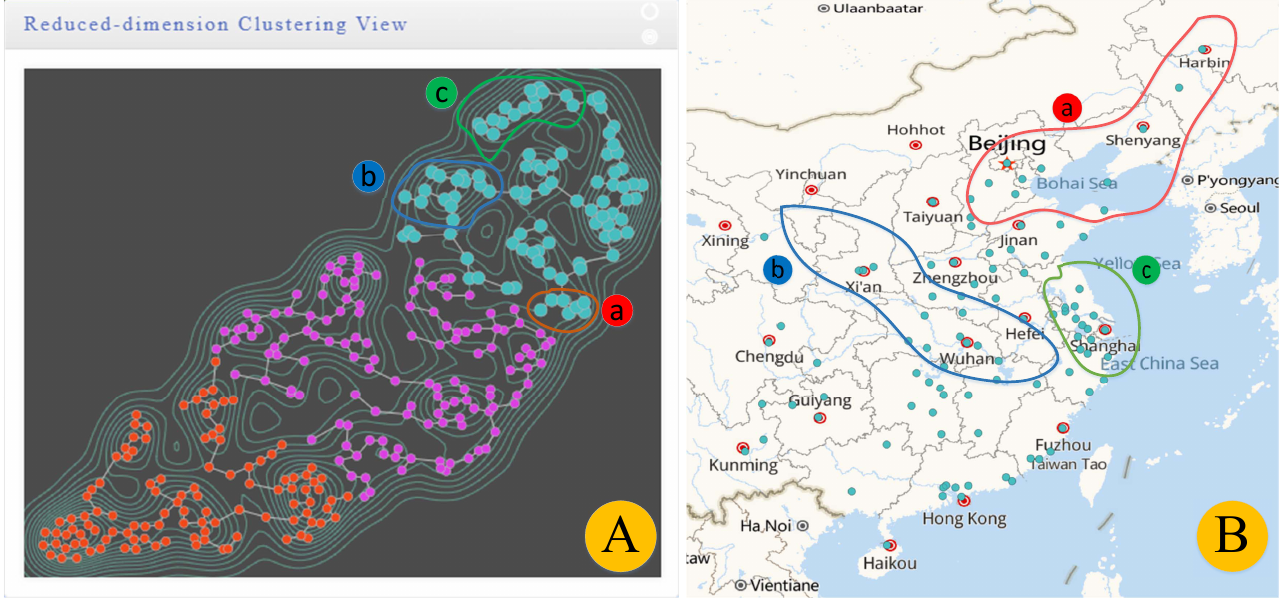
Figure 10. Interactive analysis of clustering results. ( A ) Selection of three parts in the reduced- dimensional clustering view using the lasso tool. ( B ) Three parts related to ( A ) in the map